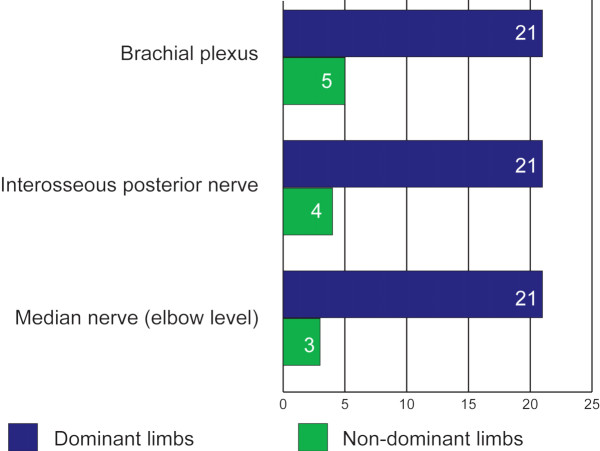
Mechanical allodynia with mild pressure at three locations along nerves in 21 dominant limbs compared to the contra-lateral limb.